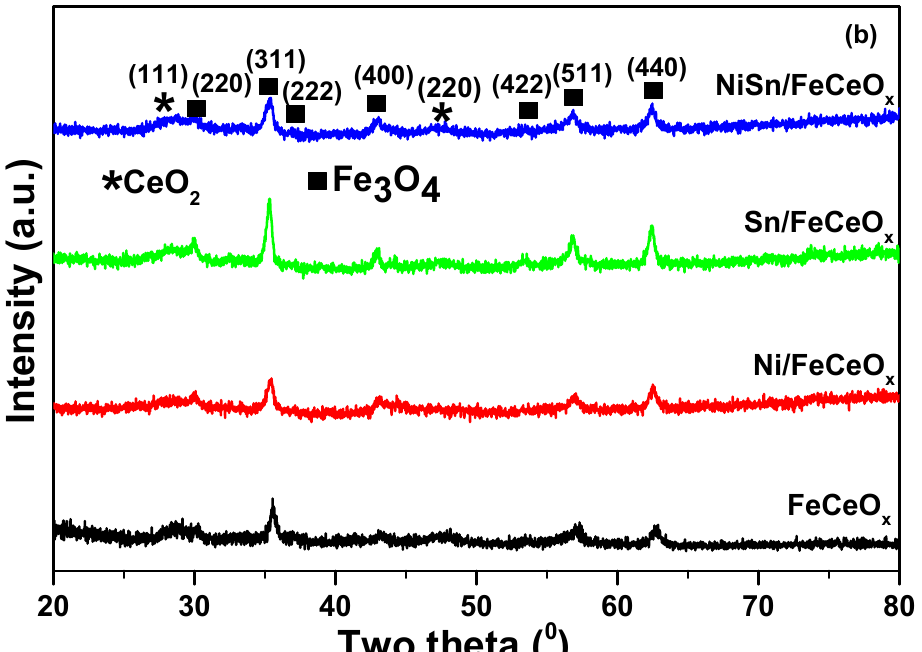
Figure3. XRDpatternsof( a )fresh( b )reducedFeCeO x ,Ni / FeCeO x ,Sn / FeCeO x ,andNiSn / FeCeO x catalysts. Figure 3. XRD patterns of ( a ) fresh ( b ) reduced FeCeO x , Ni/FeCeO x , Sn/FeCeO x , and NiSn/FeCeO x catalysts.